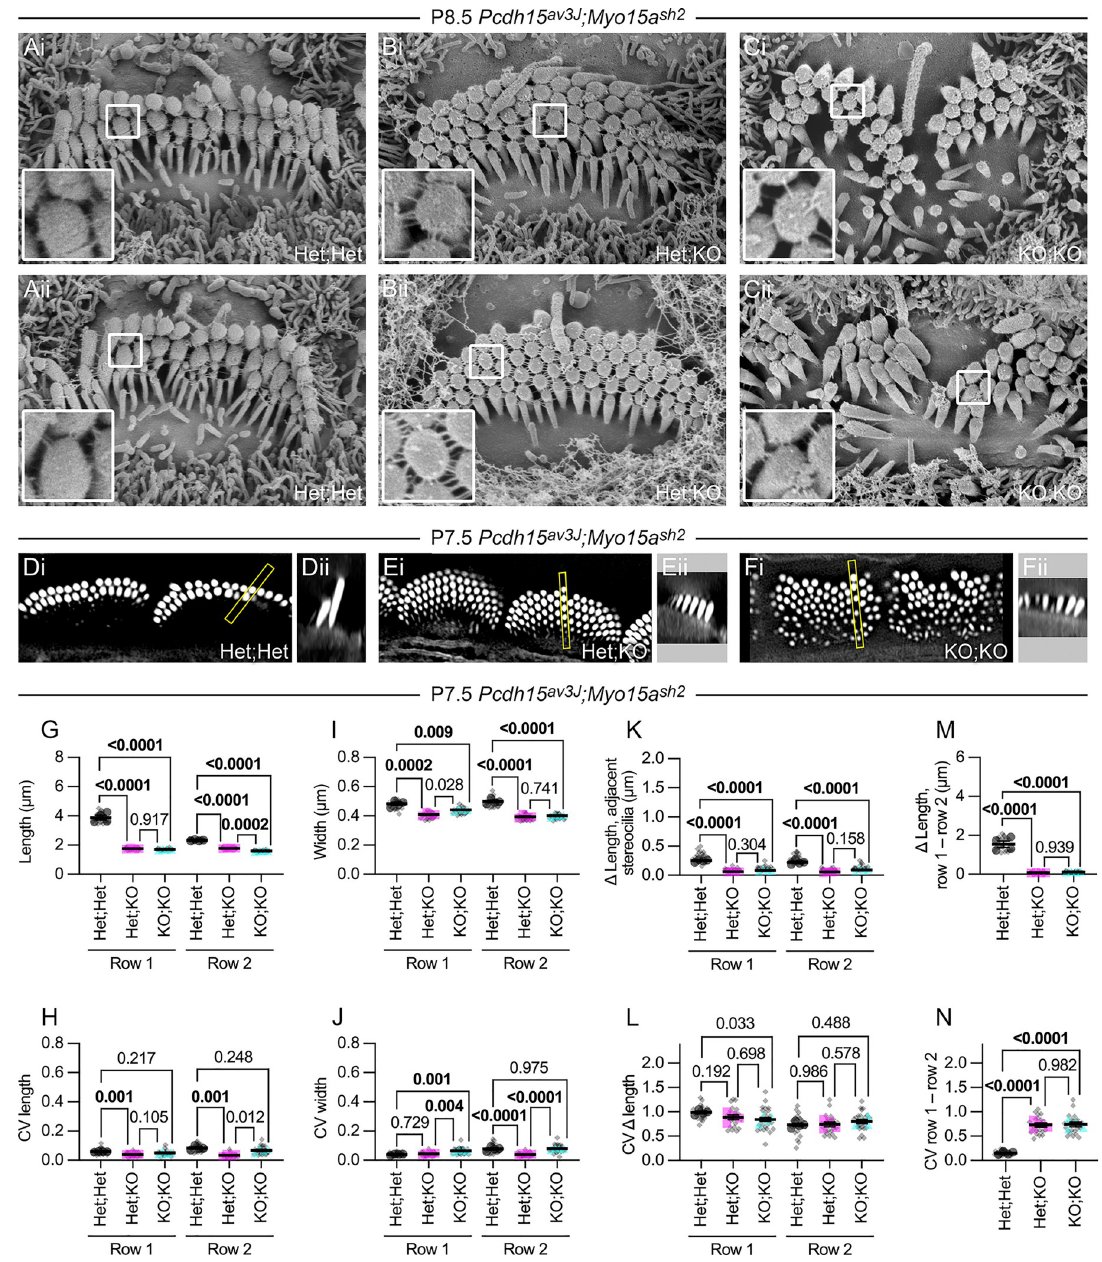
Fig 6. Pcdh15 av3J ; Myo15a sh2 double-knockout mice. ( A–C ) Scanning electron micrographs of single IHC hair bundles from P8.5 cochleas of indicated Pcdh15 av3J /+; Myo15a sh2 /+ (Het;Het), Pcdh15 av3J /+; Myo15a sh2/sh2 (Het;KO), and Pcdh15 av3J/av3J ; Myo15a sh2/sh2 (KO; KO) cochleas (2 examples per genotype). Panel widths, 6 μ m. Inserts are 0.5 μ m wide and are magnified 3-fold on left; arrows indicate tip links. ( D–F ) Phalloidin-labeled IHC hair bundles from Het;Het, Het;KO, and KO;KO cochleas. Panels labeled i (20 μ m wide) are single x-y planes from image stacks; panels labeled ii (same scale as i panels) are x-z reslices from those stacks, with the region of the stack indicated with a yellow box in i. ( G–N ) Dimension measurements using reconstructed stereocilia surfaces. Plotting was as in Fig 3; statistical tests used one-way ANOVA analysis with the Sˇida´k correction. ( G, H ) Length and CV length measurements. ( I, J ) Width and width CV measurements. ( K, L ) Difference in length ( Δ length) and CV for Δ length of side-by-side row 1 stereocilia. ( M, N ) Difference in length ( Δ length) and CV for Δ length of in-column (adjacent rows 1 and 2) stereocilia. The data underlying all the graphs shown in the figure can be found in figshare (https://doi.org/10.6084/m9.figshare.21632636.v2). CV, coefficient of variation; IHC, inner hair cell.